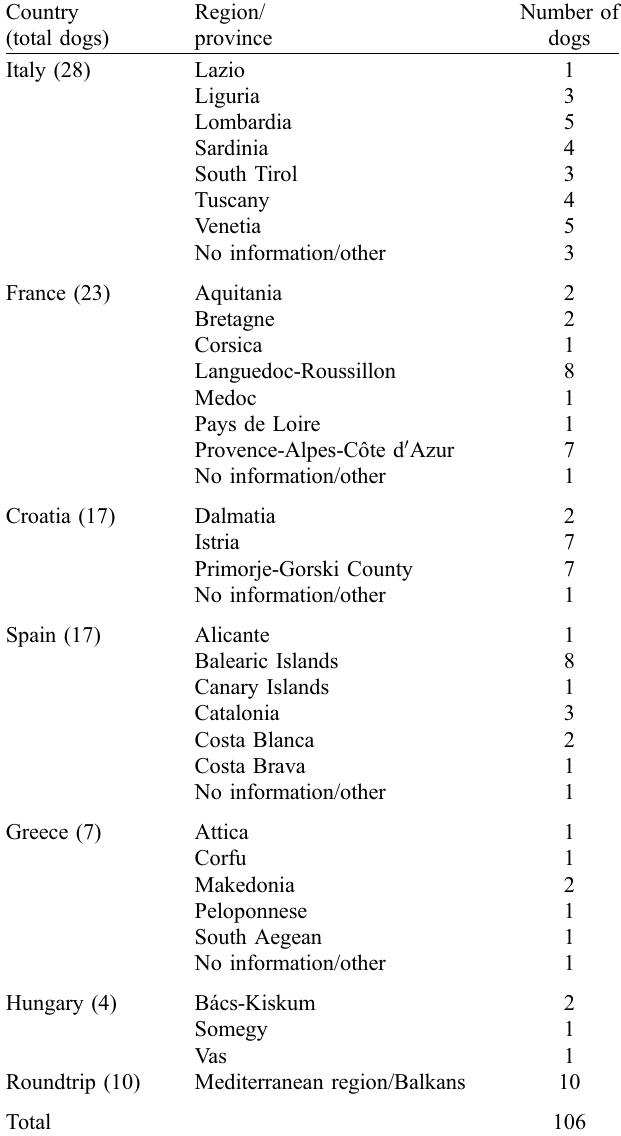
Table 3. Travel destination by country and